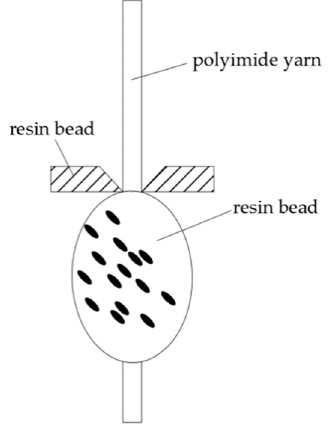
Figure 2. The extraction force test device.